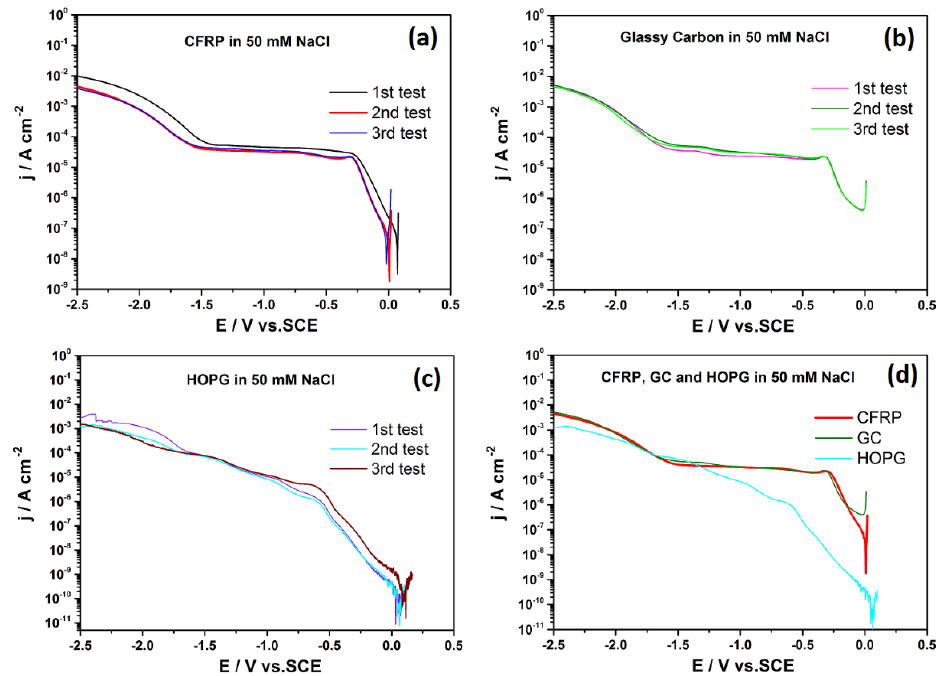
Figure 2. Comparison of cathodic potentiodynamic polarization curves of CFRP, HOPG, and glassy carbon in 50 mM NaCl acquired at scan rates of 1 mV s −1 . ( b ) HOPG ( c ), CFRP + GC+HOPG ( d ), in 50 mM NaCl acquired at scan rates of 1 mV s − 1